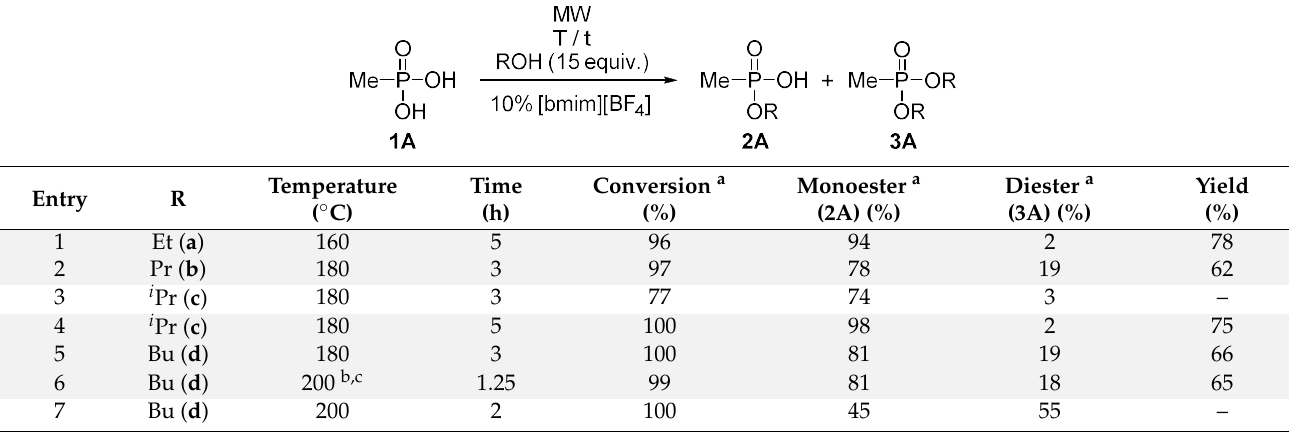
The results obtained with methylphosphonic acid ( 1A ) are summarized in Table 1. Due to the volatility and taking into account the pressure limit of the MW reactor, the esterification with EtOH had to be carried out at 160 ◦ C. The almost complete conversion was attained after an irradiation of 5 h. The ratio of the mono and the diester ( 2Aa and 3Aa ) was 94–2 (Table 1/Entry 1). The reactivity of PrOH and i PrOH was significantly different, after a reaction at 180 ◦ C for 3 h, the conversion was 97% and 77%, respectively, while the proportion of the mono and diesters ( 2Ab / 2Ac and 3Ab / 3Ac ) was 78–19 and 74–3, respectively (Table 1/Entries 2 and 3). Using i PrOH, the conversion was complete after 5 h (Table 1/Entry 4). Employing BuOH, the appropriate reaction conditions were either 180 ◦ C/3 h or 200 ◦ C/1.25 h. In these cases, the ratio of 2Ad and 3Ad was ca. 81:19 (Table 1/Entries 5 and 6). On the effect of prolonged heating, the ratio of the diester 3Ad increased to 55% (Table 1/Entry 7). It is noteworthy that a control experiment carried out in the lack of [bmim][BF 4 ] took place in a conversion of 19% (Table 1/Entry 6, footnote “b”). Hence, the role of IL is unambiguous. In another comparative experiment performed on conventional heating without IL, the conversion was 10% (Table 1/Entry 6, footnote “c”). This proves that both MW and IL are needed for efficient esterification. Table 1. Direct esterification of methylphosphonic acid ( 1A ) in the presence of [bmim][BF 4 ] under MW conditions.